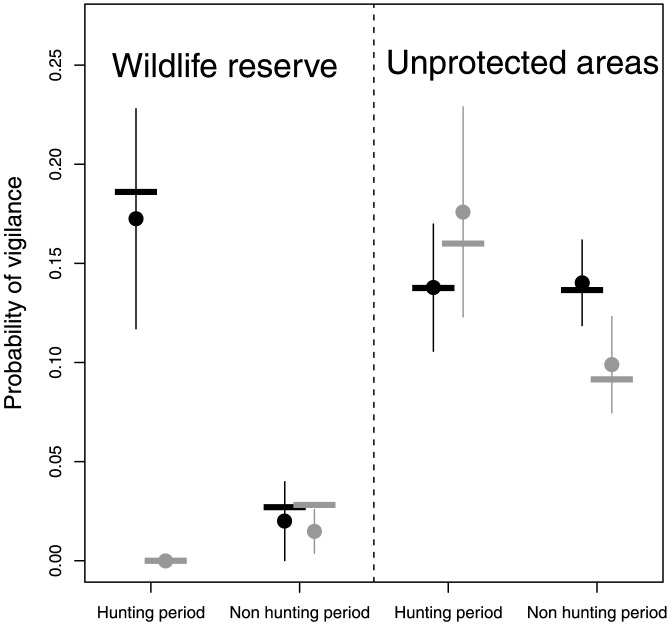
Representation of the best logistic model explaining adult male vigilance according to WR/UA and period of hunting/non hunting (Table 2).Female estimates for a model including the same interaction than males (area status×hunting period) were reported for comparison. Grey circles (± SE) correspond to females and black circles correspond to males. Each circle was drawn along with an horizontal thick line showing the observed proportion of vigilance for the corresponding sex and levels of the factors (observed proportions were computed for the full range of group size and visibility values in females). The predicted probabilities were associated with the level of “low quality feeding sites” for adult males, and with the level of “females with lamb”, the average group size and the average visibility in the home ranges for adult females.